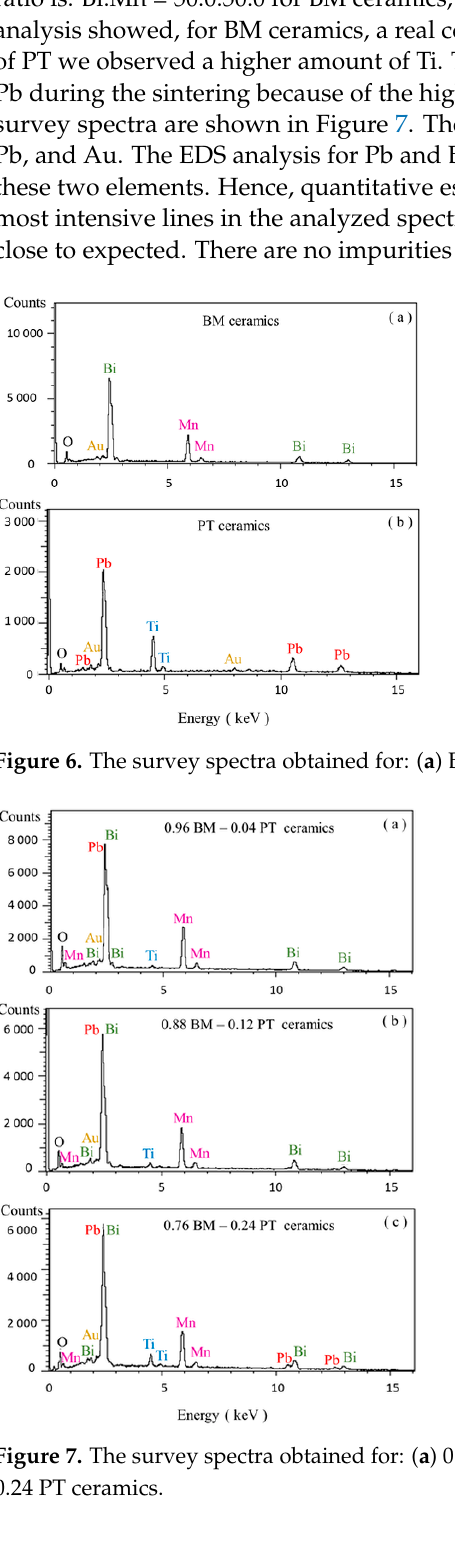
Figure 5. Secondary electron images obtained for the composite ceramics: BM ( a ), 0.98 BM–0.02 PT ( b ), 0.96 BM–0.04 PT ( c ), 0.92 BM–0.08 PT ( d ), 0.88 BM–0.12 PT ( e ), 0.84 BM–0.16 PT ( f ), and 0.76 BM–0.24 PT ( g ).